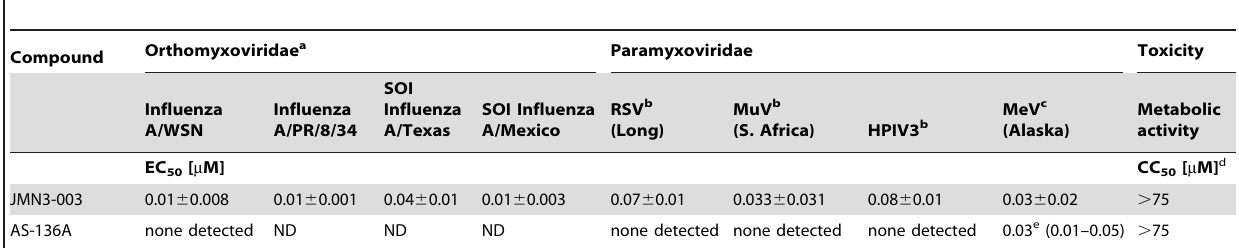
Table 1. Active (EC 50 ) and toxic (CC 50 , determined on Vero-Slam cells) concentrations of JMN3-003 against a selection of clinically relevant para- and orthomyxovirus family members in comparison with active concentrations of AS-136A, a previously characterized, MeV-specific inhibitor of the viral RdRp complex